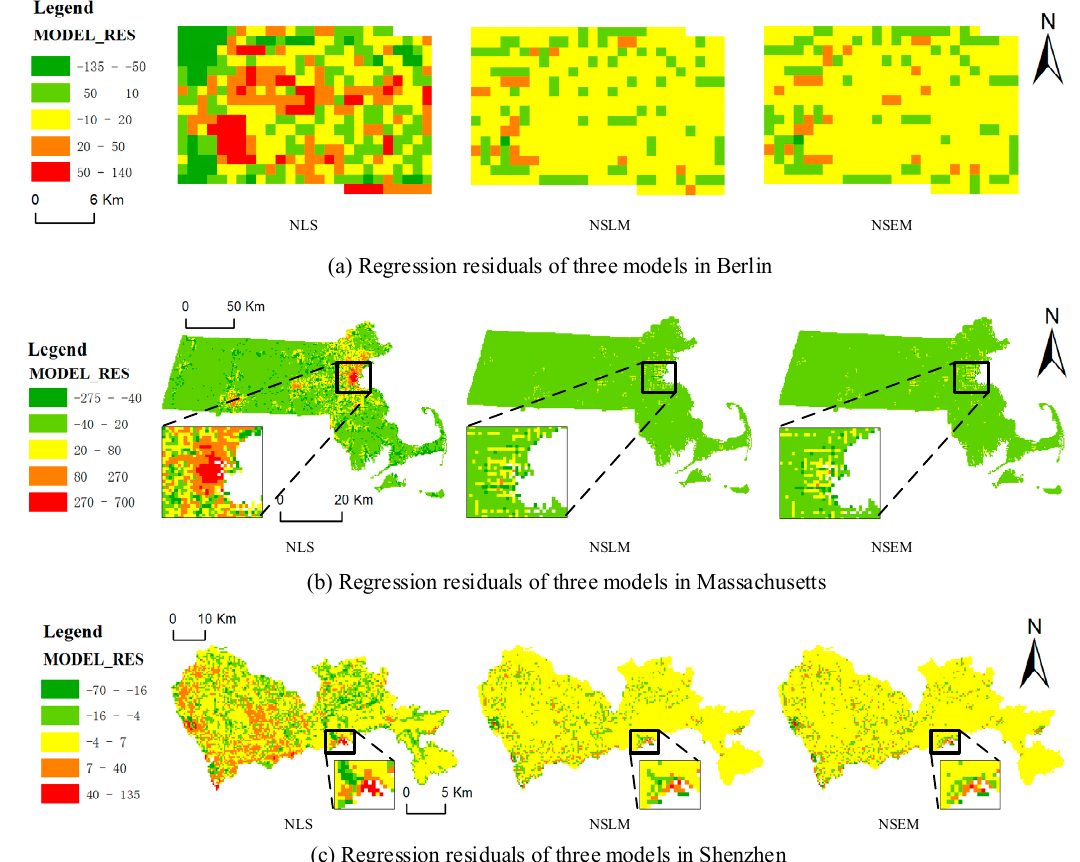
Figure 6. Spatial distributions of residuals of the three regression models in the three study areas. Table 3. Moran’s I values of regression residuals and residual accumulations in three study areas. Study Areas